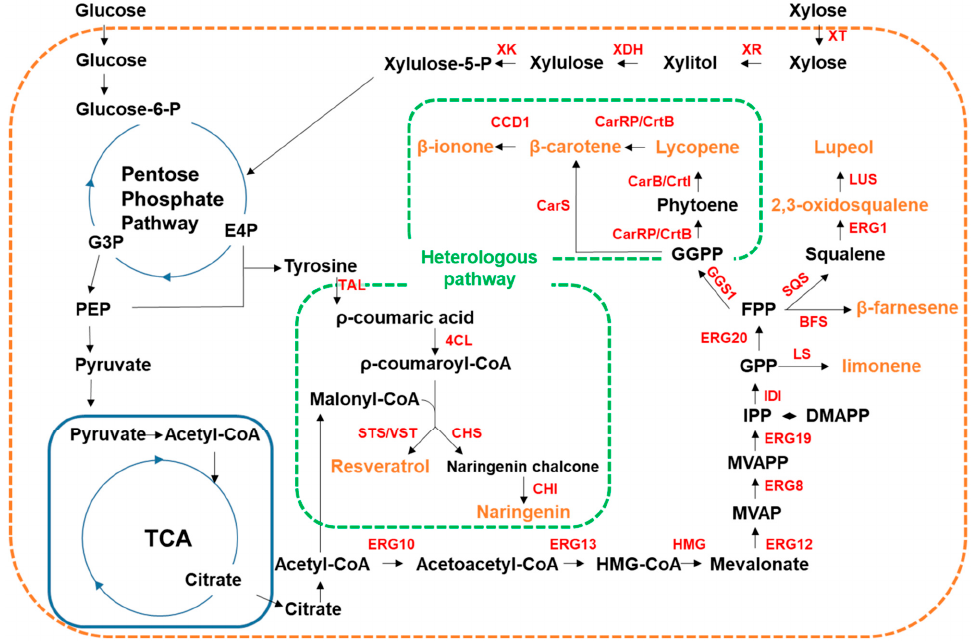
Figure 3. Engineered metabolic pathways for the production of secondary plant metabolites, such as flavonoids and carotenoids, in NCYs. Abbreviations: glucose-6-P, glucose-6-phosphate; xylulose-5-P, xylulose-5-phosphate; E4P, erythrose 4-phosphate; G3P, glyceraldehyde-3-phosphate; PEP,